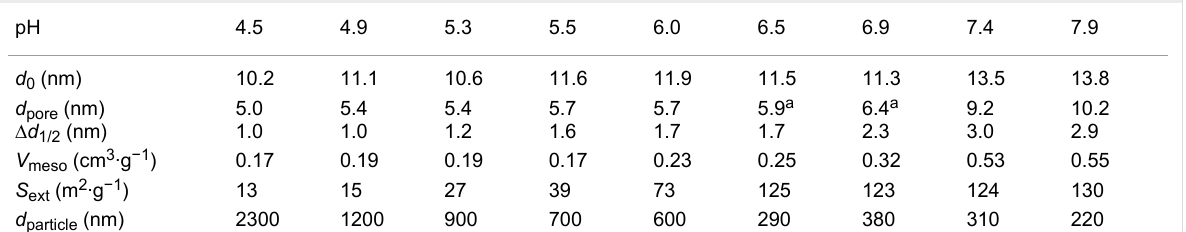
Table 1: Textural and structural properties of the calcined materials synthesized at 3.9 wt % DHBC: lattice parameter ( d 0 ), pore diameter ( d pore ), full width at half maximum of the pore size distribution ( ∆ d 1/2 ), mesoporous volume ( V meso ), external surface area ( S ext ) of the particles and particle size ( d particle ).